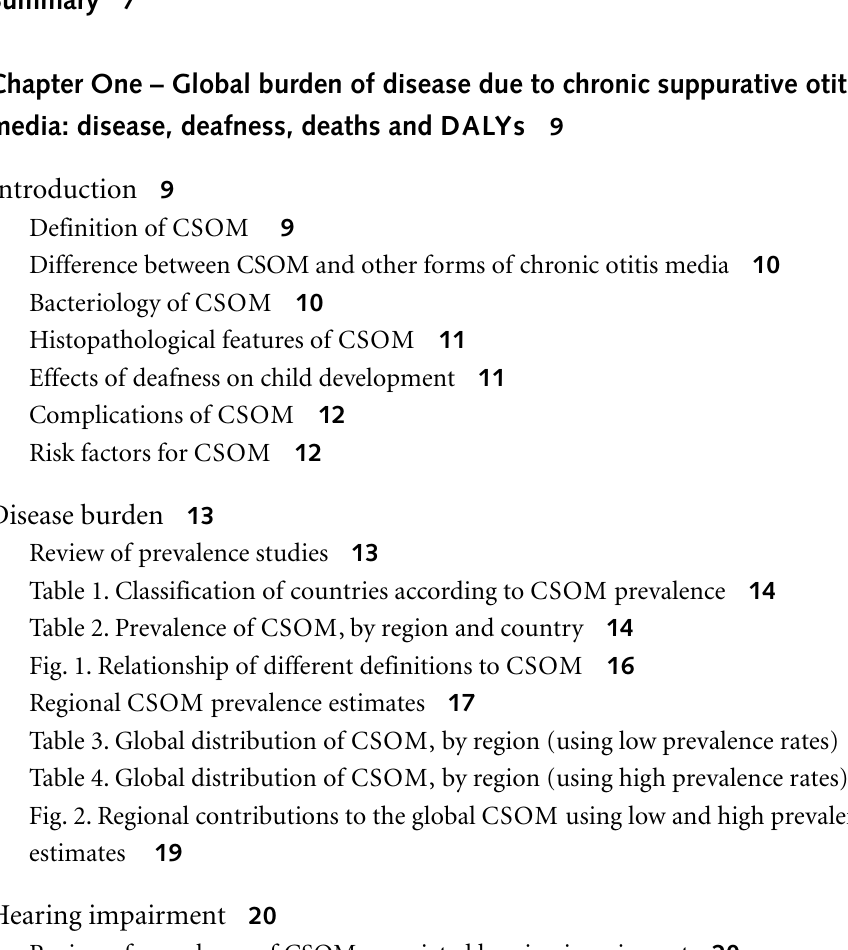
Table 1. Classification of countries according to CSOM prevalence 14 Table 2. Prevalence of CSOM, by region and country 14 Fig. 1. Relationship of different definitions to CSOM 16 Table 3. Global distribution of CSOM, by region (using low prevalence rates) 19 Table 4. Global distribution of CSOM, by region (using high prevalence rates) 19 Fig. 2. Regional contributions to the global CSOM using low and high prevalence